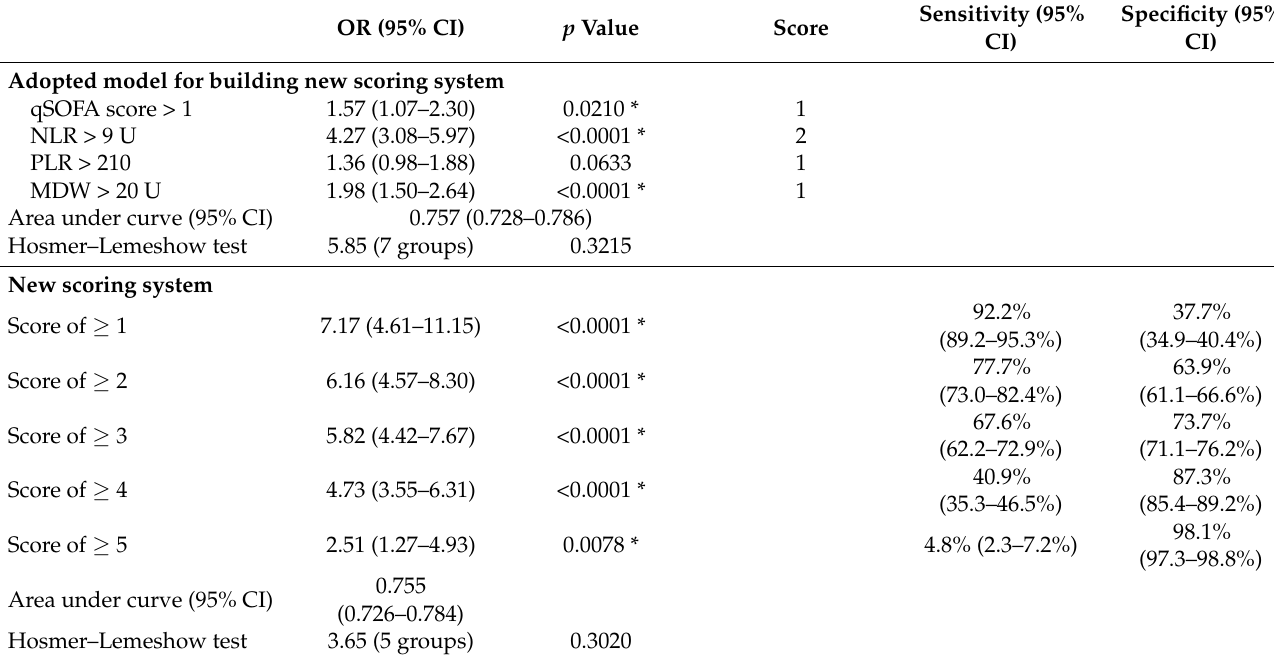
Table 5. New Scoring Systems and Laboratory Tests for Predicting